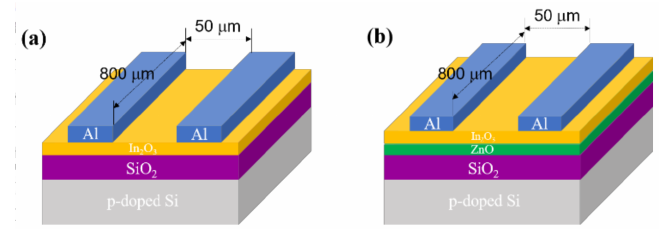
Figure 2. ( a ) Single-layer In 2 O 3 thin-film transistor (TFT) and ( b ) bilayer ZnO/In 2 O 3 TFT.